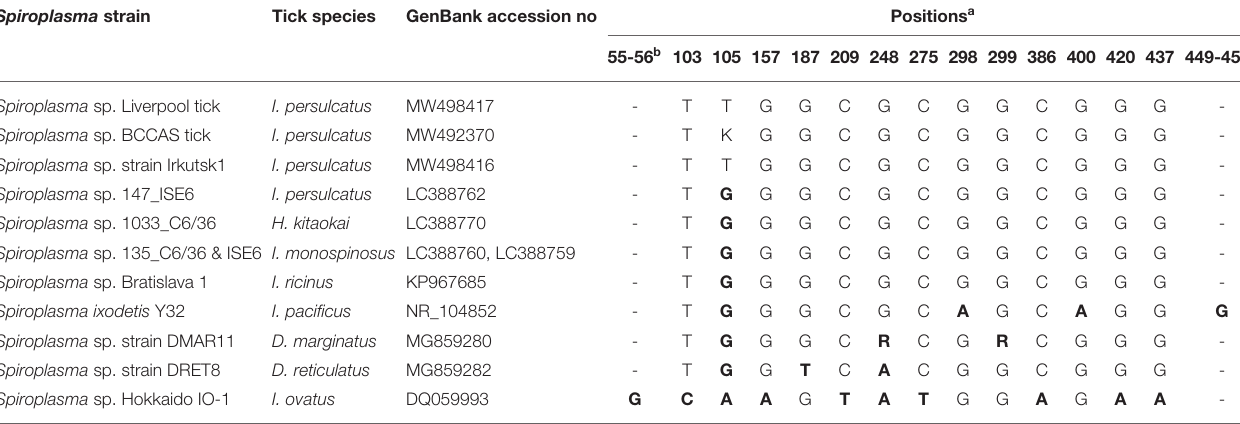
Polymorphisms in the 16S rRNA gene fragment of the Spiroplasma sp. detected in whole third-generation I. persulcatus colony ticks sampled at University of Liverpool (Liverpool tick) and at the Institute of Parasitology, Biology Centre, Czech Academy of Sciences (BCCAS tick) and isolated from I. persulcatus (strain Irkutsk1) compared to other Spiroplasma strains isolated from hard tick species I. persulcatus, Ixodes monospinosus, Ixodes ricinus, Ixodes pacificus, Ixodes ovatus, Haemaphysalis kitaokai, Dermacentor marginatus and Dermacentor reticulatus. a The number corresponds to the positions of nucleotide substitutions with respect to the sequences MW498416 and MW498417 amplified in this study. Corresponding base substitutions are shown. The substitutions compared to the sequences amplified in this study are shown in bold. b There is an insertion between these two nucleotide bases in one sequence, a gap (-) is marked when this insertion does not occur. K = G or T; R = A or